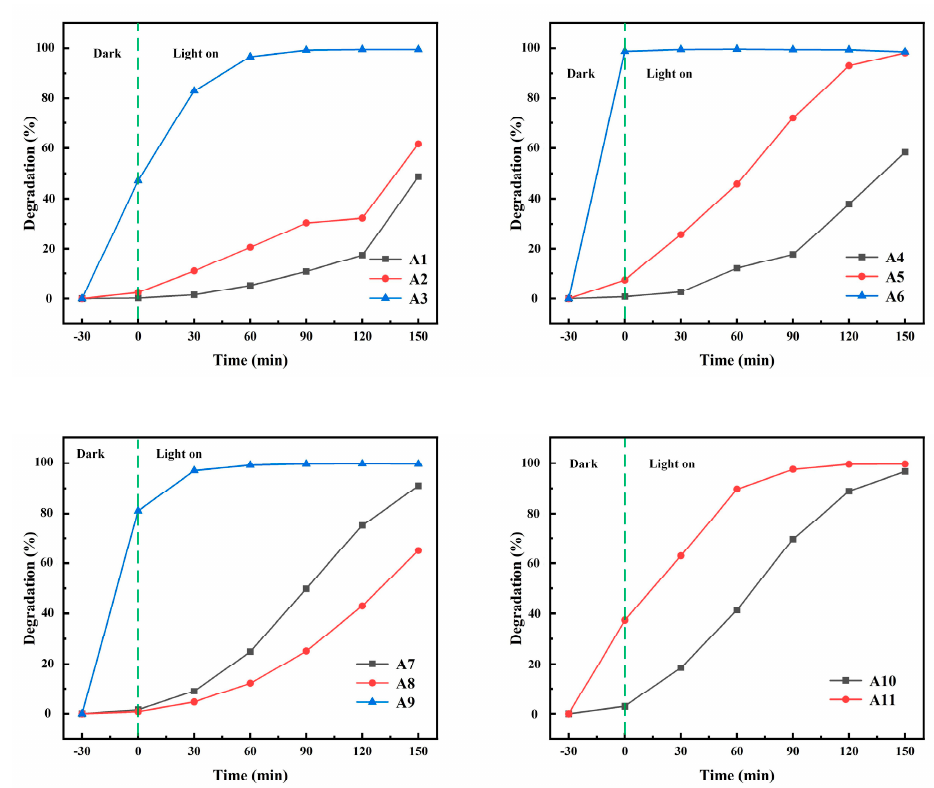
Figure 9. The relationship between degradation rate of MB and time.